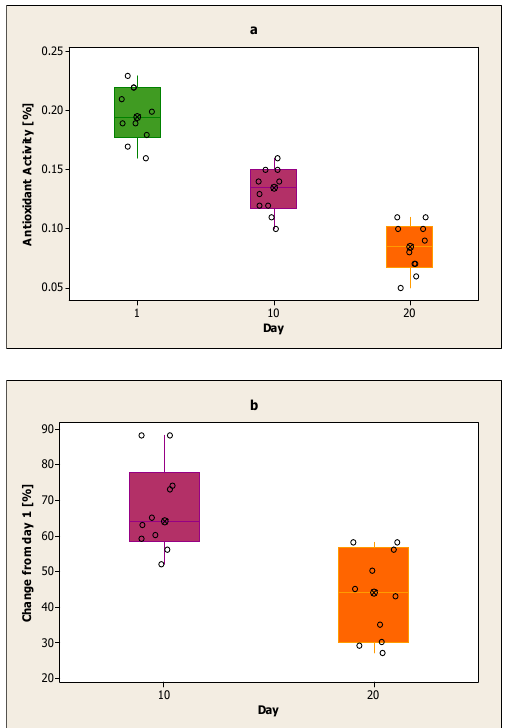
Figure 1. ( a ) Antioxidant activity of the control sample on the first day, the 10th day and the 20th day; ( b ) Decline on day 10 and day 20 for the control sample compared to day one.